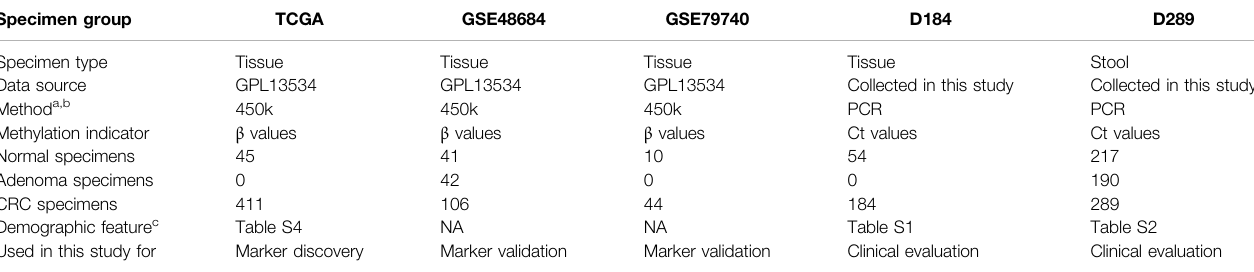
TABLE 1 | Description of the sample groups used in this study. Specimen group